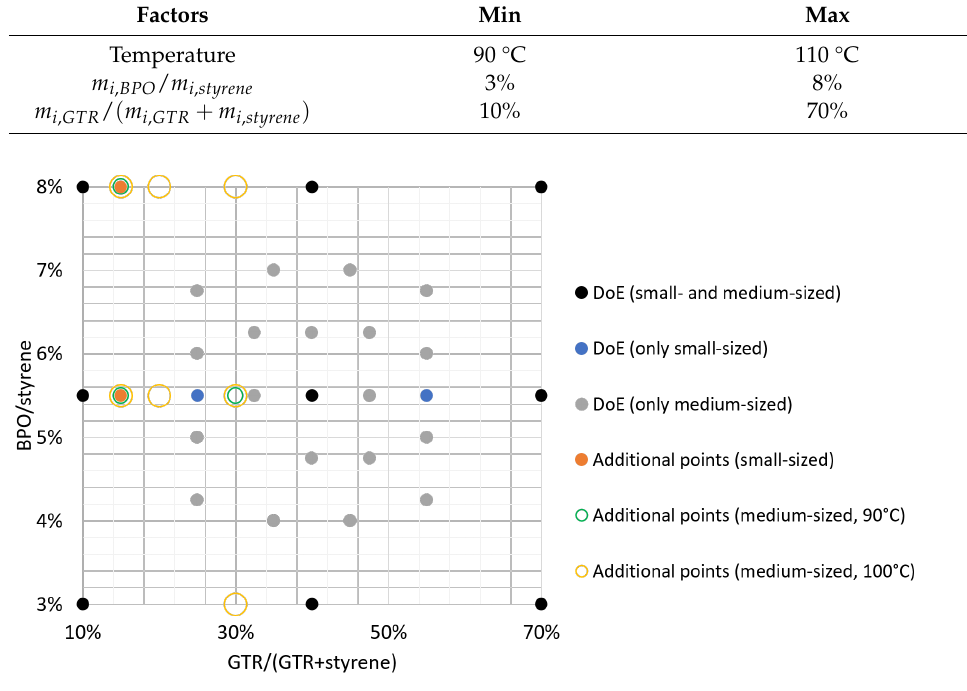
Figure 2. Design of experiments for small- and medium-sized